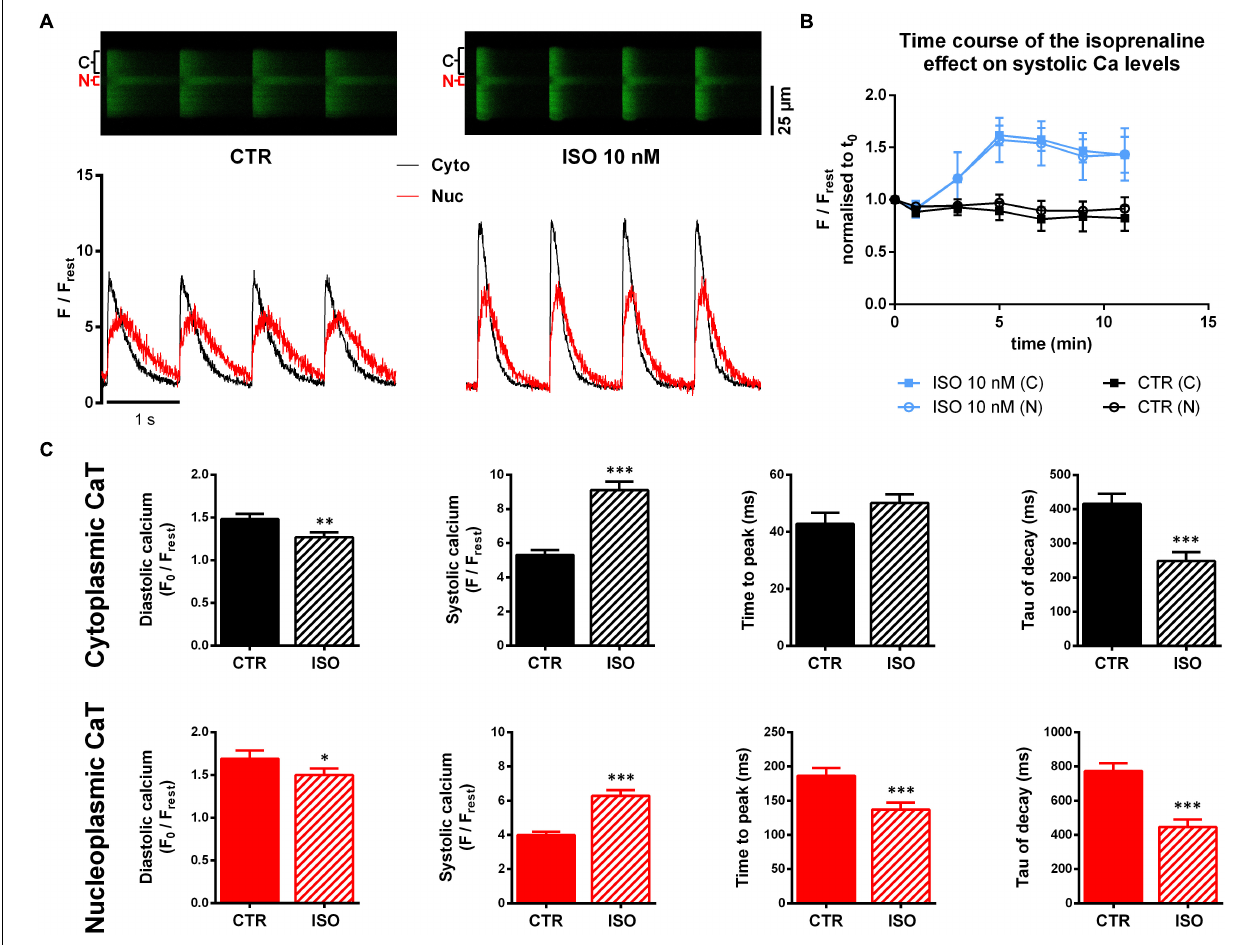
FIGURE 2 | Confocal imaging of cytoplasmic and nucleoplasmic CaTs under isoprenaline (ISO) stimulation. (A) Left panel: original line-scan registration, showing electrically stimulated cytoplasmic (C, Cyto, black) and nucleoplasmic (N, Nuc, red) CaTs under CTR conditions and the corresponding normalized fluorescence trace. Right panel: line-scan fluorescence image and normalized trace after 5 min of ISO (10 nM) exposure. (B) Pilot experiments ( n / N = 3/3 ISO; n / N = 4/1 CTR) showing the time course of the ISO effect on systolic Ca. (C) Averaged characteristics of cytoplasmic and nucleoplasmic CaTs. ∗ P < 0.05, ∗∗ P < 0.01, ∗∗∗ P < 0.001, n / N =